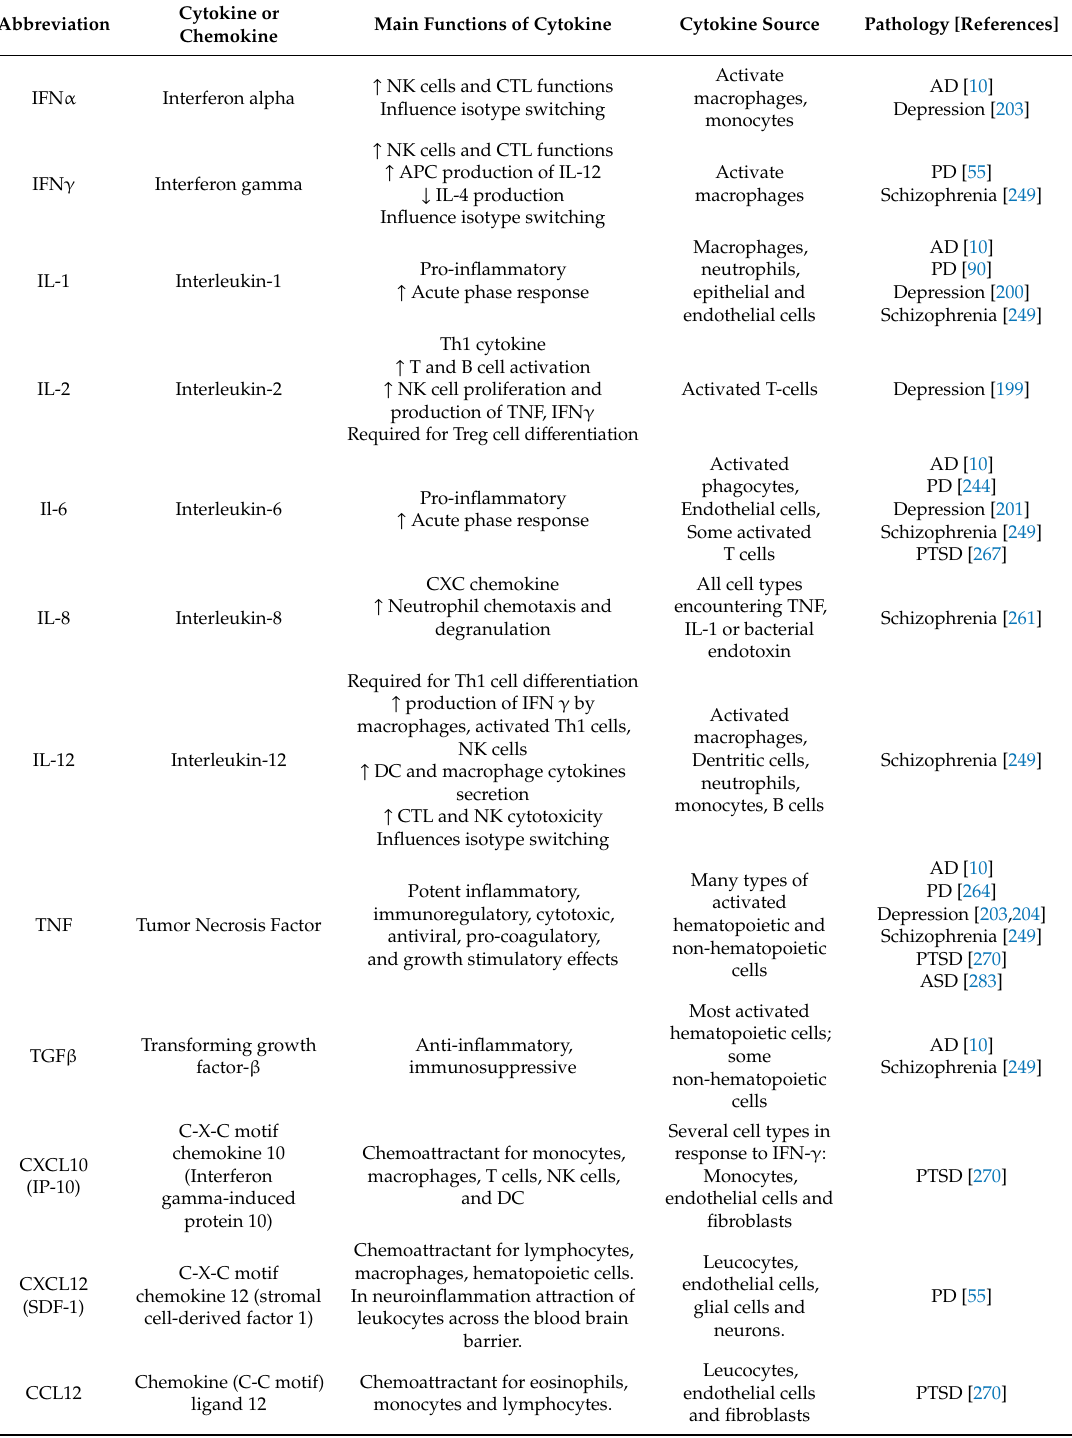
Table 1. List of cytockines and chemokines dysregulated and disease